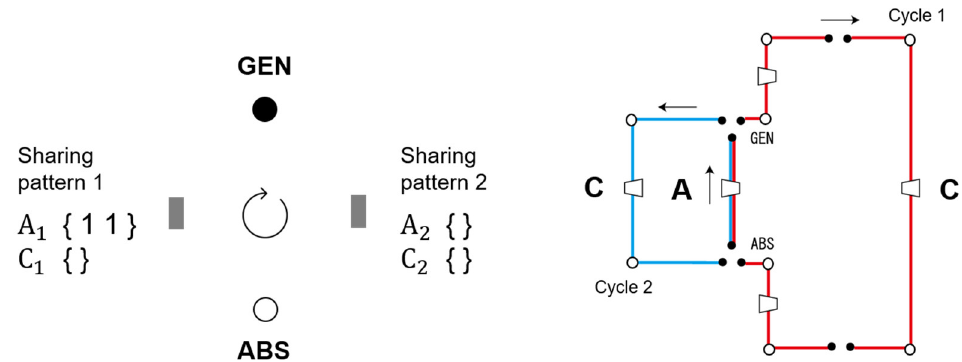
Figure 4. An example of topology definition of a basic configuration, including two elementary cycles and one absorption/generation process. (red line—refrigerant, blue line—absorbent solution).